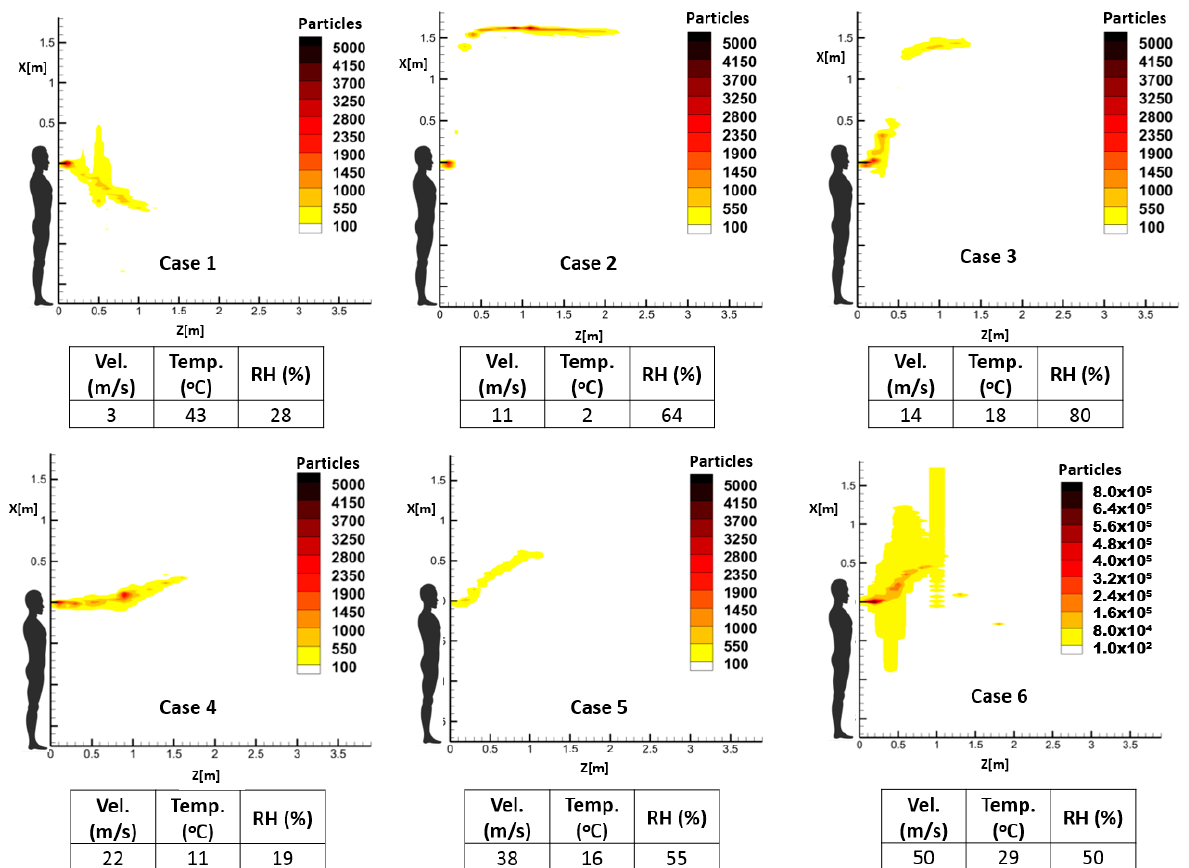
Figure 6. Risky regions with more than 100 accumulated droplets after 80 s.